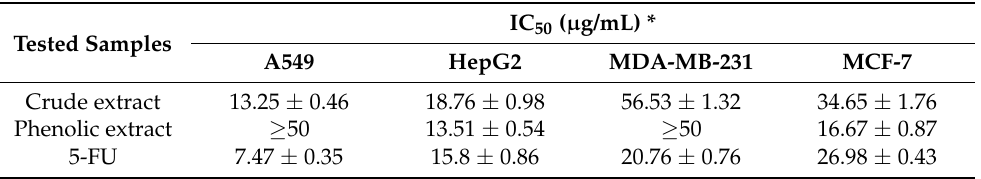
Table 1. IC 50 ( µ g/mL) * values of both crude and phenolic extracts against panels of breast, liver, and lung cancer using the MTT